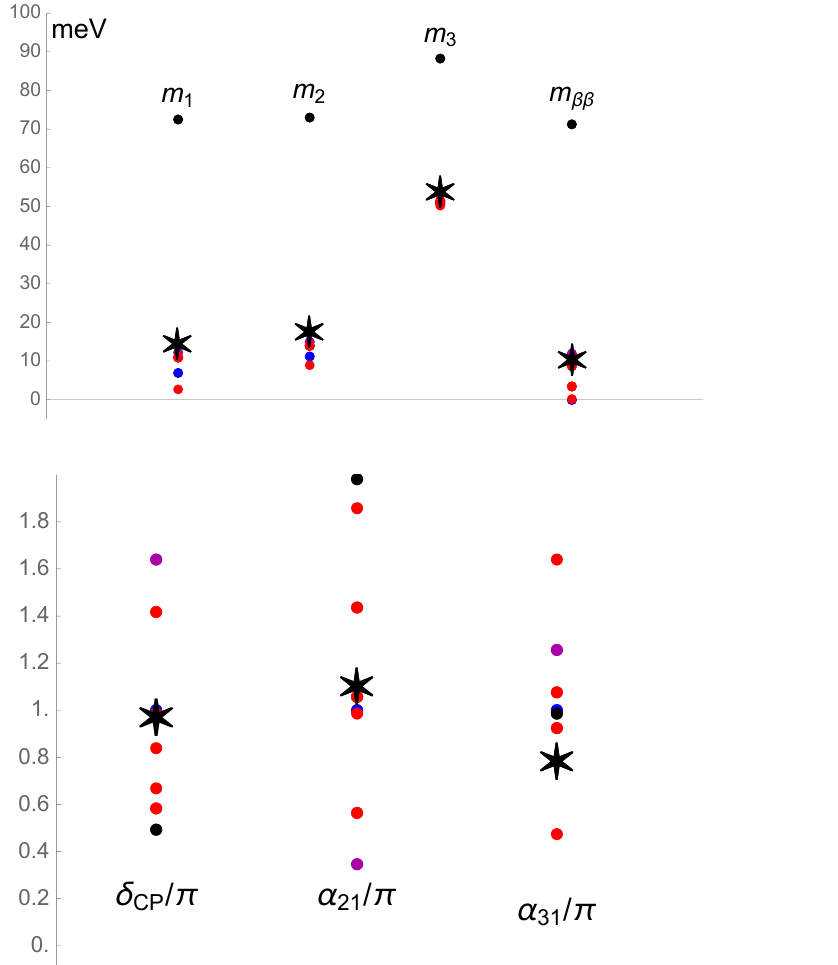
Figure 6 . Mass parameters and phases of 14 pairs of CP and modular invariant models featuring normal ordering and | τ − i | < 0 . 25 (see text). The full distributions of predictions are displayed. The color code is identical to the one in figure 4. A star shows the average over the 14 models. CP violating phases refer to models where Re τ > 0